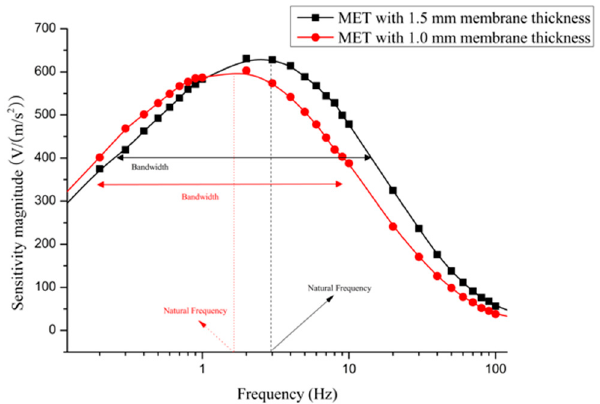
Figure 10. Frequency vs. sensitivity magnitude of the MET that is equipped with different membrane thicknesses.